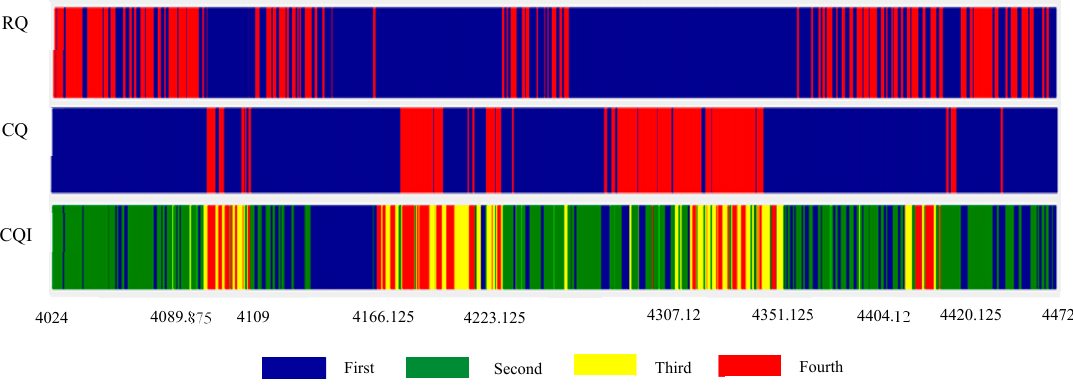
Figure 9. GMM clustering results of well A.